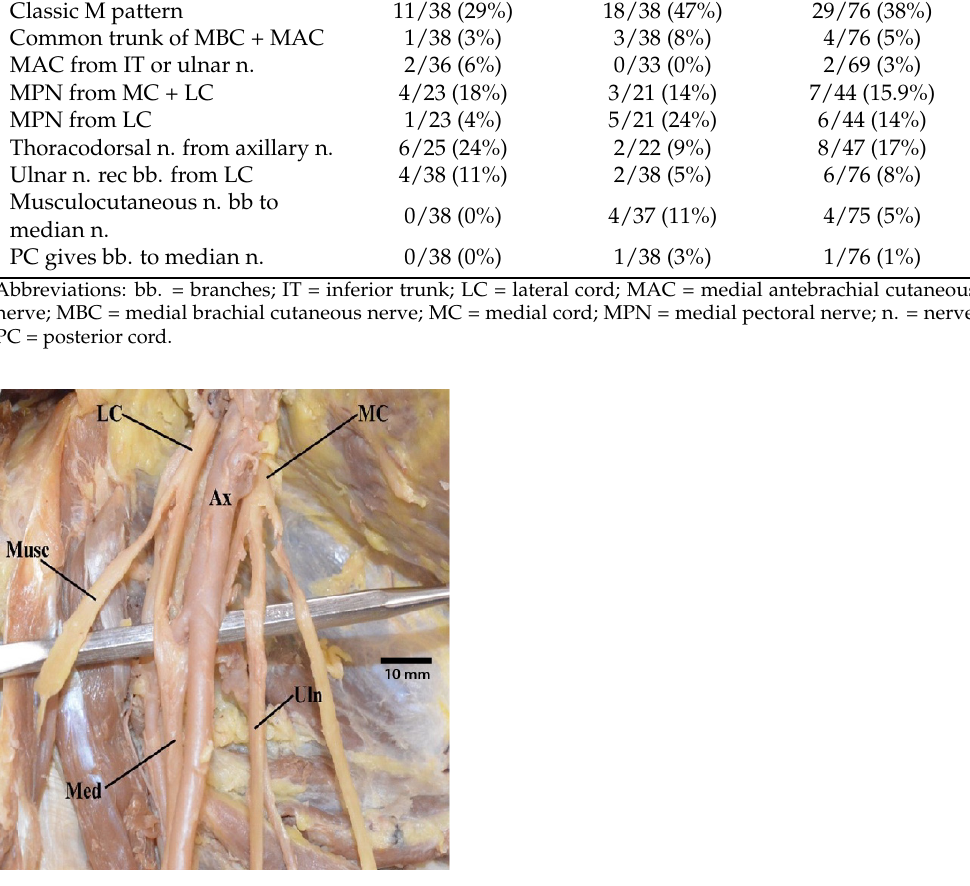
Figure 1. Photograph of the axillary artery located more anteriorly and positioned within the contents of the brachial plexus “M”. Abbreviations: Ax = axillary artery; LC = lateral cord; MC = medial cord; Med = median nerve; Musc = musculocutaneous nerve; Uln = ulnar nerve.